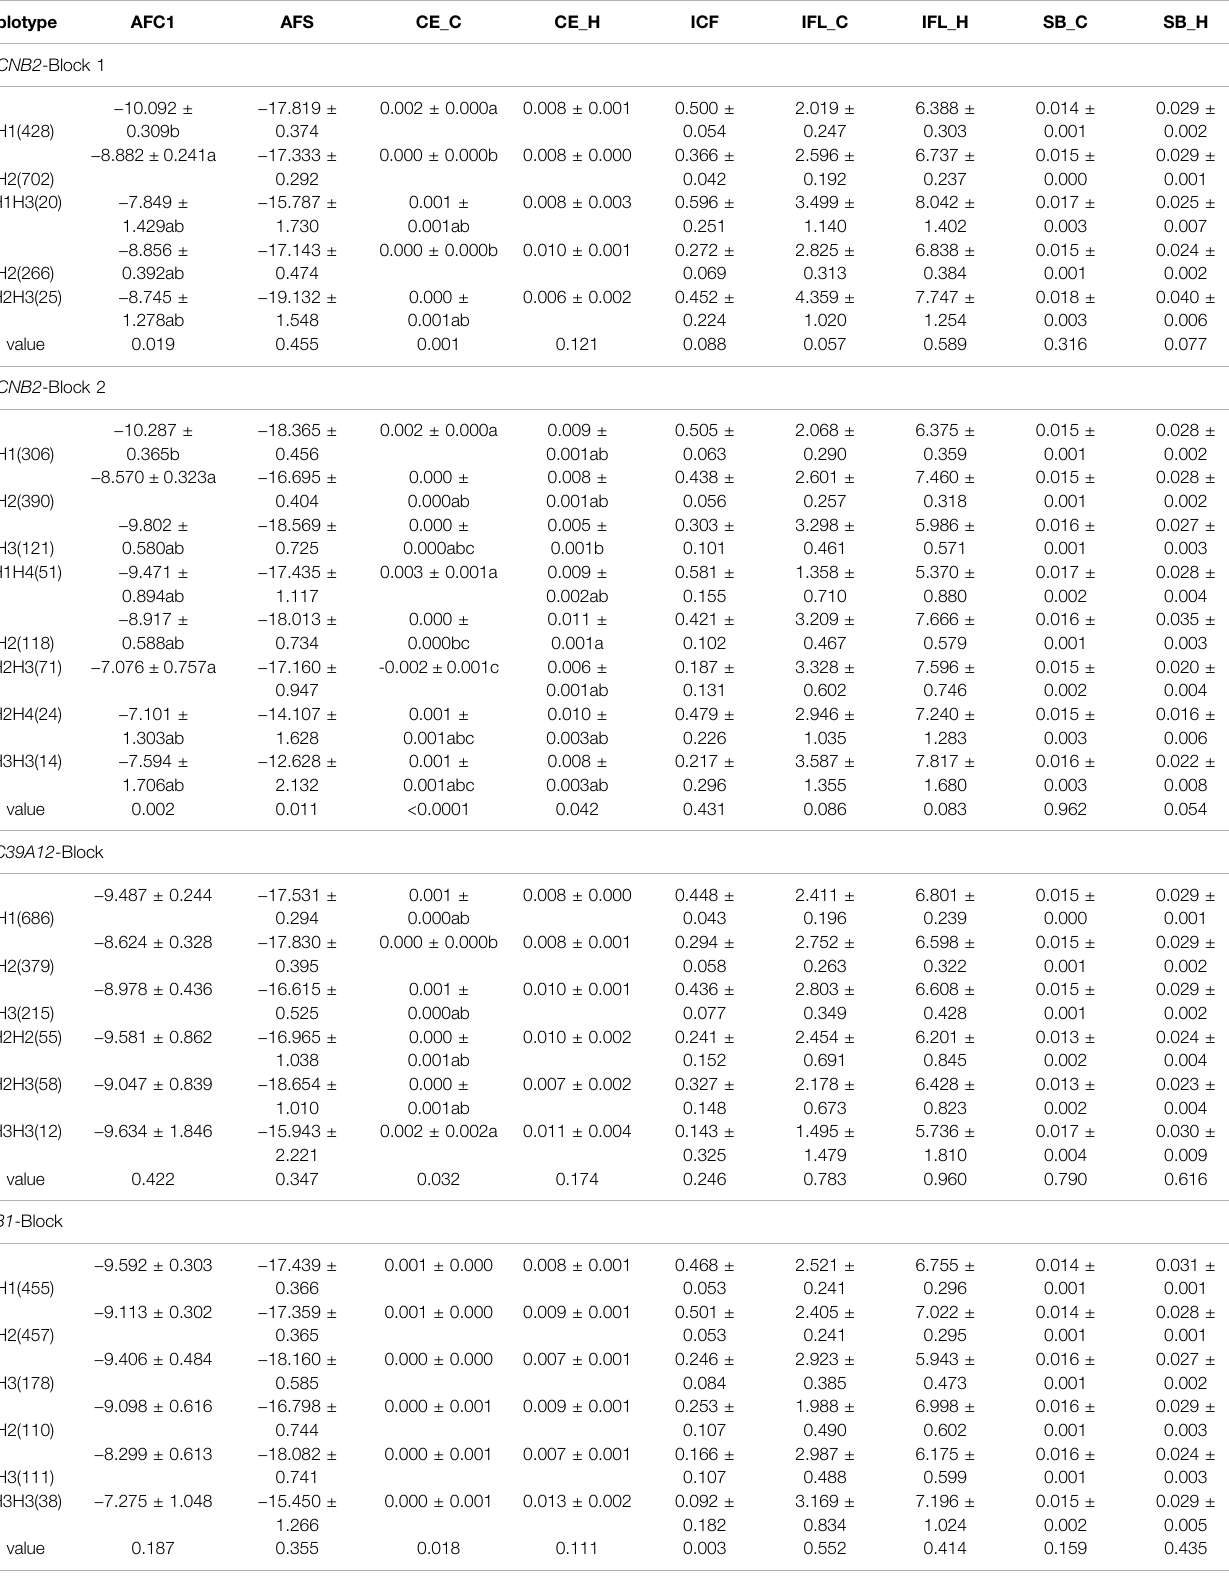
TABLE 2 | Association of haplotype blocks within gene CACNB2 , SLC39A12 and ZEB1 with reproductive traits in Holstein cows (Least Square Mean ± Standard Error).